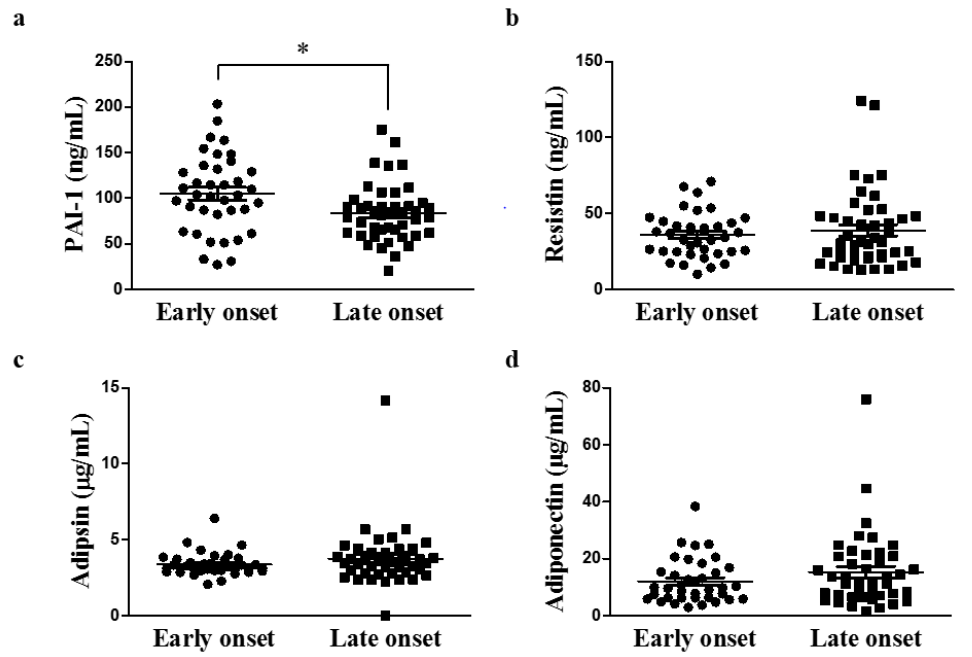
Figure 1. Comparison of serum adipokine concentrations according to age of onset of gout (early-onset group, n = 38; late-onset group, n = 45; * p < 0.05). ( a ) PAI-1 ( b ) Resistin ( c ) Adipsin ( d ) Adiponectin. PAI-1, plasminogen activator inhibitor-1.